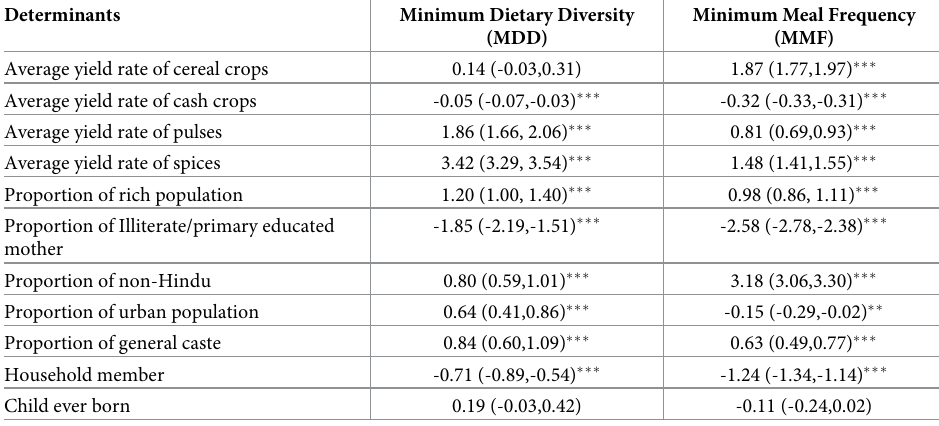
Table 2. Result of OLS regression analysis showing the relation between crop yield rate and MDD & MMF in India, 2015–16.